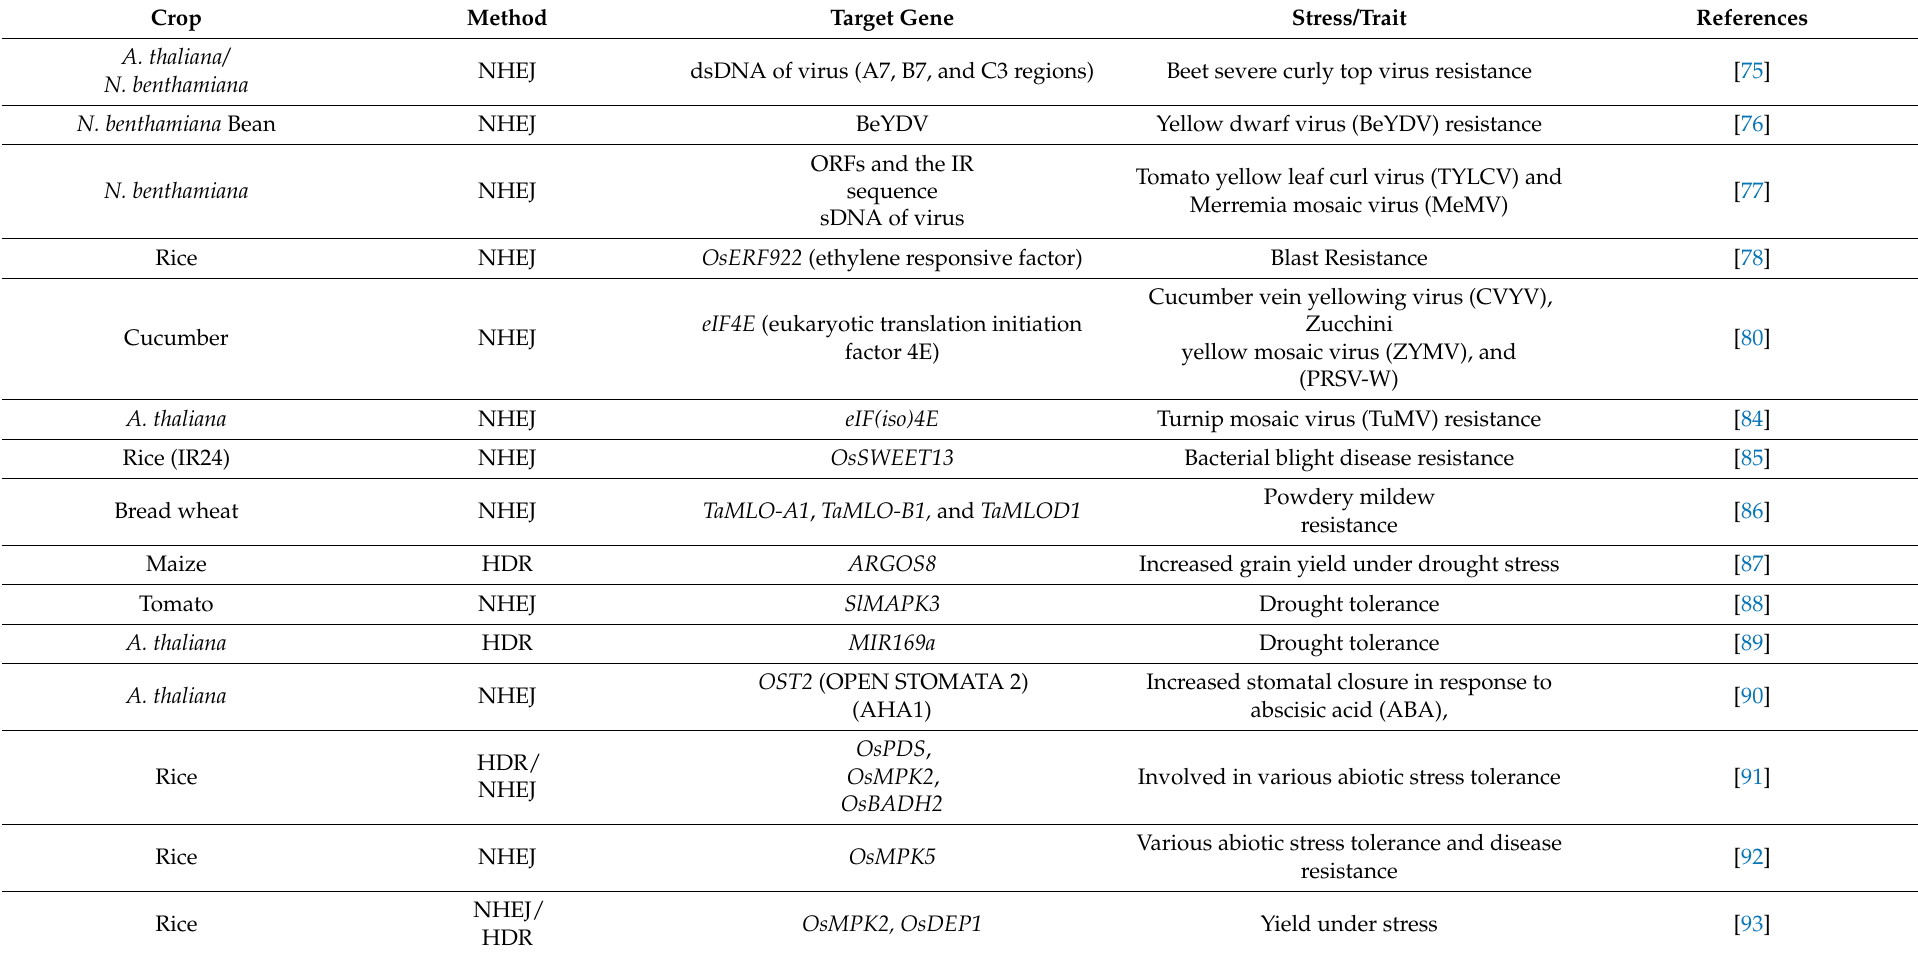
Table 7. Several examples of the application of CRISPR-Cas9 technology in plants against environmental